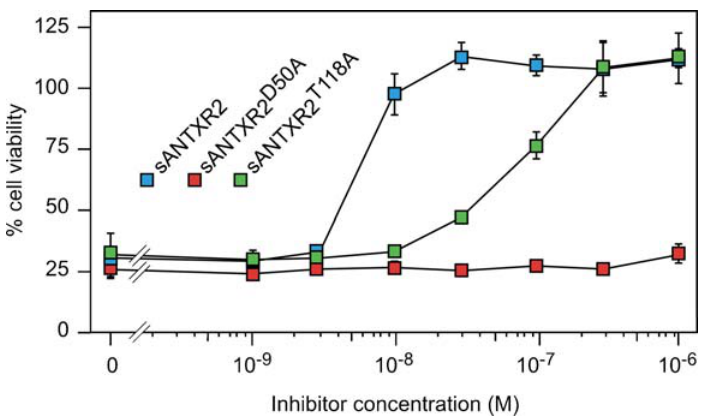
Figure 3. Soluble ANTXR2 T118A inhibits intoxication of cells. WT and mutant sANTXR2 proteins were added in increasing amounts to measure their relative abilities to block CHO-K1 cell intoxication with PA (10 2 8 M) and LF N -DTA (10 2 10 M). Cell viability was subsequently measured using the WST-1 assay and is represented as the percentage of that seen with cells incubated with LF N -DTA alone (100% viable).